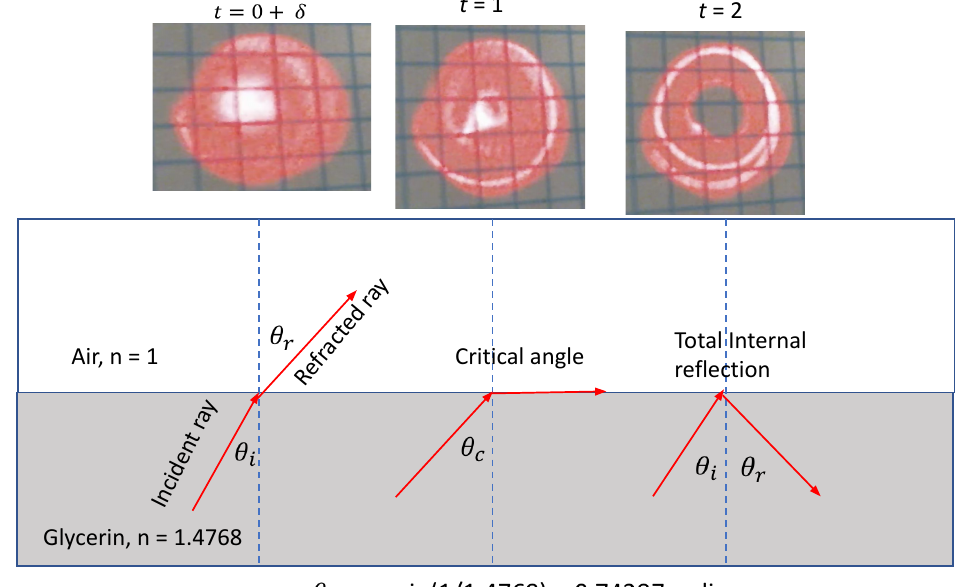
Figure 3. A possible explanation of the pressure-induced analog black hole. See [42] for refractive index study as function of pressure.